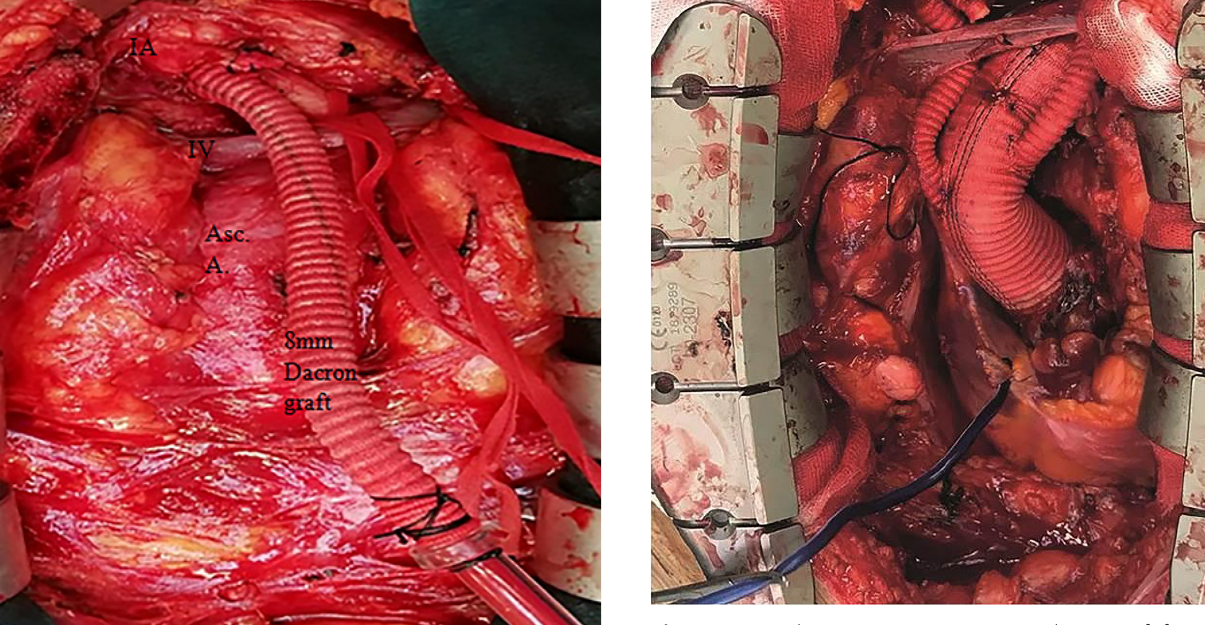
Fig. 2 - Using the innominate artery cannulation graft for proximal arch repair. In this patient, who underwent ascending aorta and proximal arcus replacement (innominate artery and left common carotid artery), the graft was anastomosed to the aortic graft for proximal arch repair after decannulation of the innominate artery.